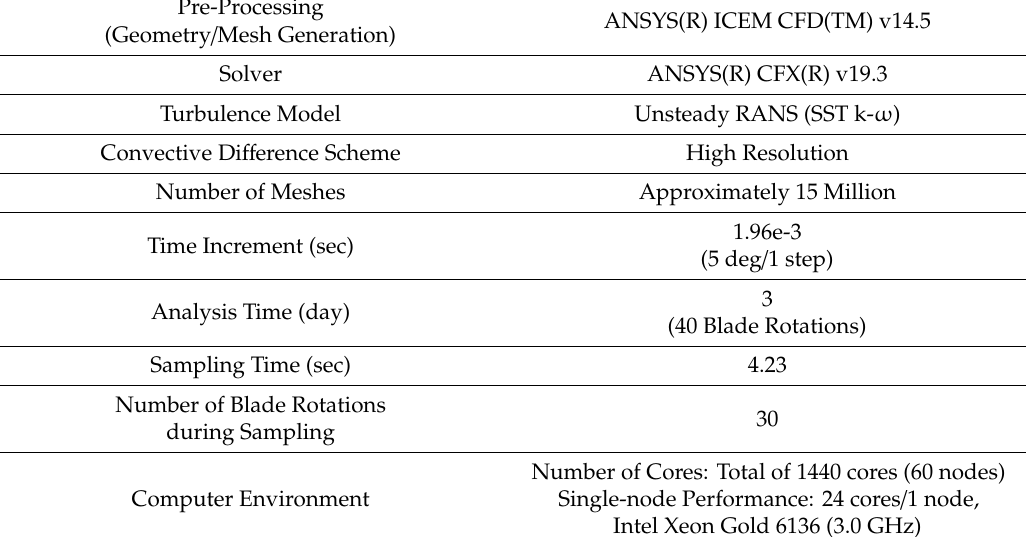
Table 1. Simulation conditions for the 1 / 88 scale wind turbine model. RANS: Reynolds-averaged